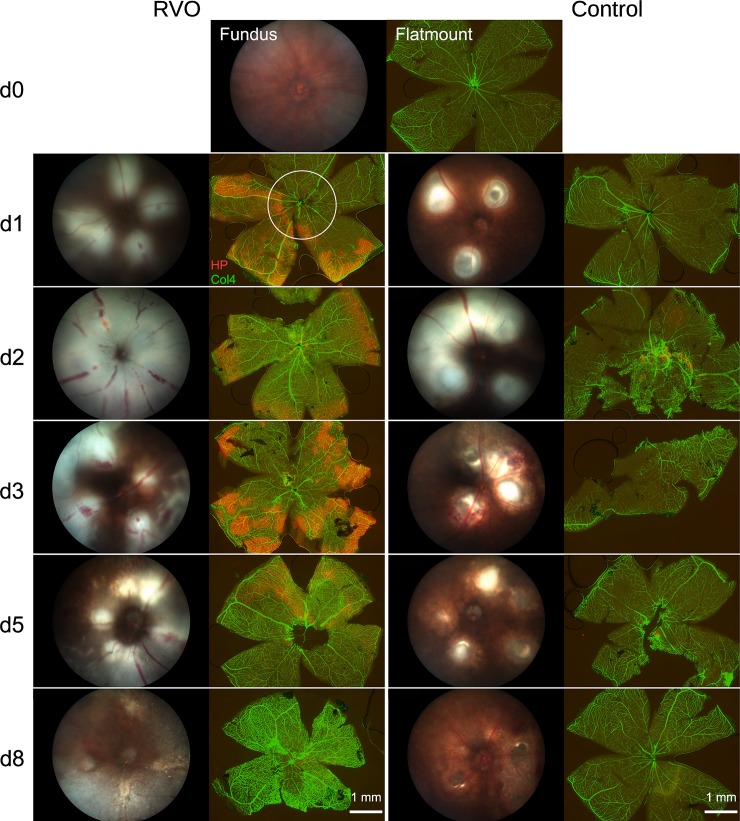
Time course of RVO and hypoxia.RVO was induced at d0 in two mice per time point. Fundus images were taken by a Micron III camera and flatmounts were prepared at the indicated days. Flatmounts were stained for vessels with an antibody raised against collagen IV (Col4, green) and with hypoxyprobe (red) for hypoxic areas. Flatmounts at d0 were not laser-treated. In one eye of each mouse, the veins were occluded (RVO) while the other eye was laser-treated between the large vessels (control). The circle indicates the area of the corresponding fundus image. Hypoxic areas were found from d1 to d3, diminished at d5 and disappeared completely at d8. No hypoxia staining was observed after intervenous laser treatment in the control group. The large edematous areas (gray areas of the fundus images) at the laser sites were observed both in the RVO and the control group. They resulted in weaker hypoxia staining (compare the RVO eye at d2).